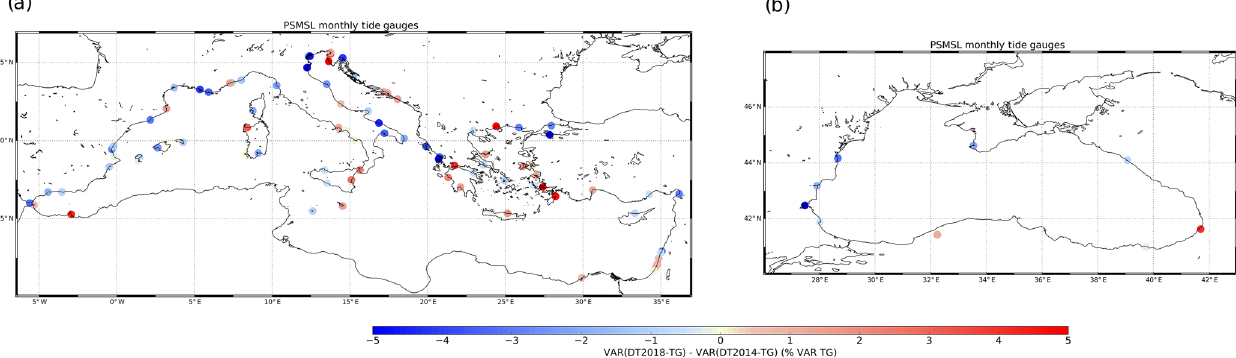
Figure 10. Difference of the variance between regional Mediterranean gridded (a) and regional Black Sea (b) SLA products and TG succes- sively using DT2018 and DT2014 gridded products. We used mean monthly TG measurements from the PSMSL network. Negative values represent reduced differences between DT2018 altimetry gridded SLA and TG. The statistic is expressed as a percentage of the RMS of TG measurements. The statistic is expressed as a percentage of the RMS of the independent along-track product.